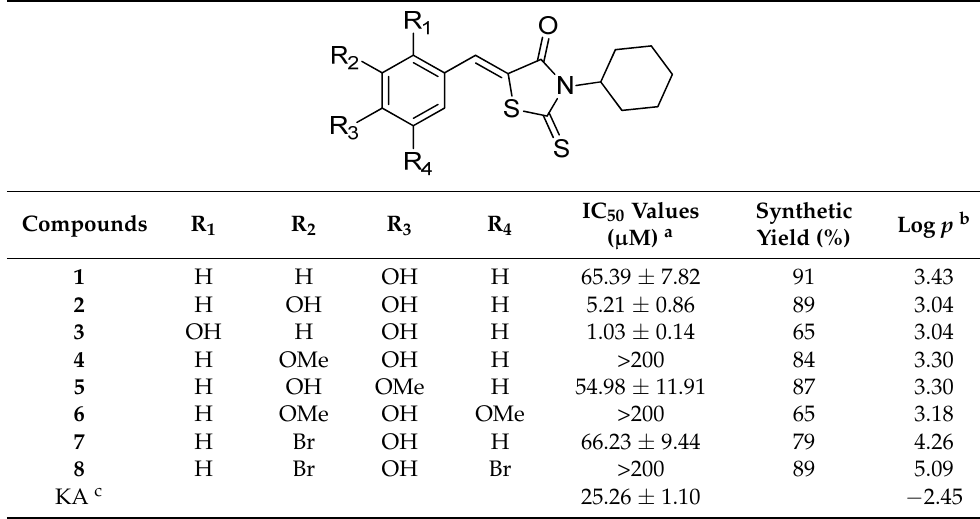
Table 2. IC 50 values, synthetic yields, and log p values of ( Z )-5-(substituted benzylidene)-3-cyclohexyl-2-thioxothiazolidin-4-one analogs 1 – 8 .